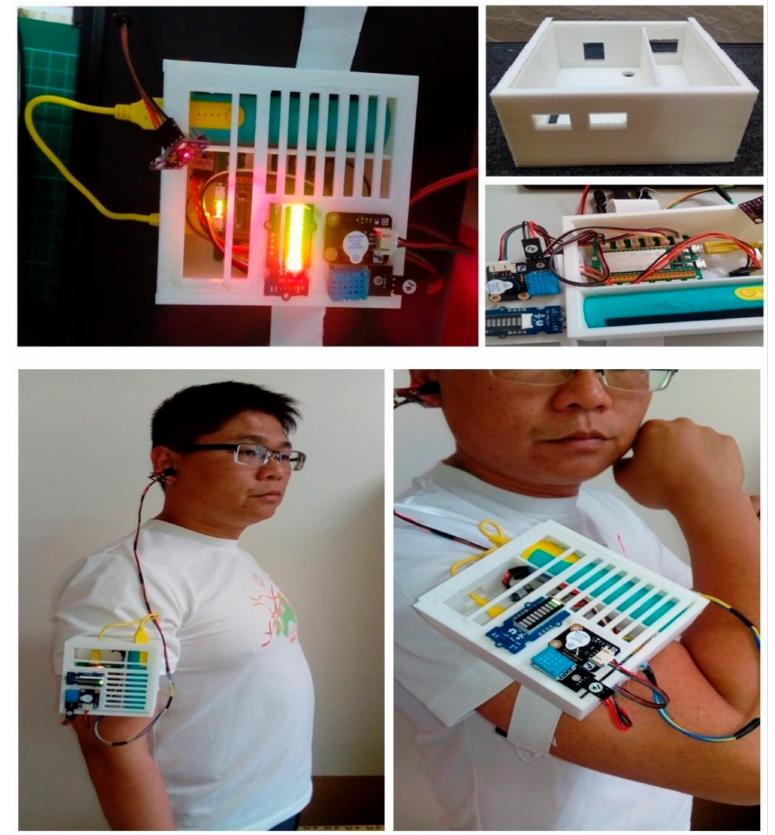
Figure 14. Fitness training machine model management